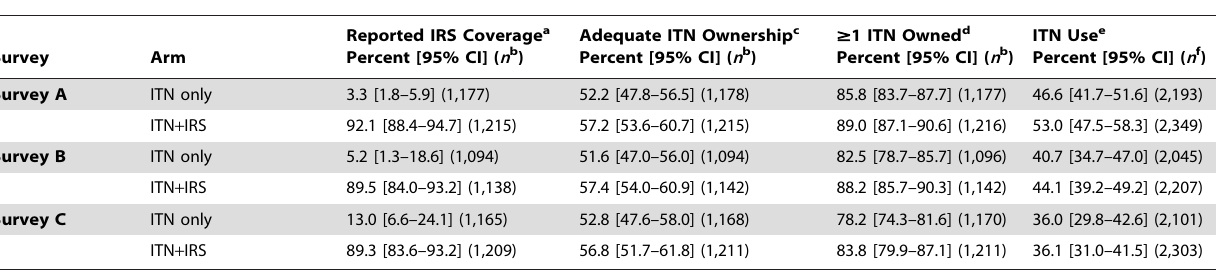
Table 3. IRS coverage, ITN ownership, and ITN usage in the intervention year, Muleba District, 2012.